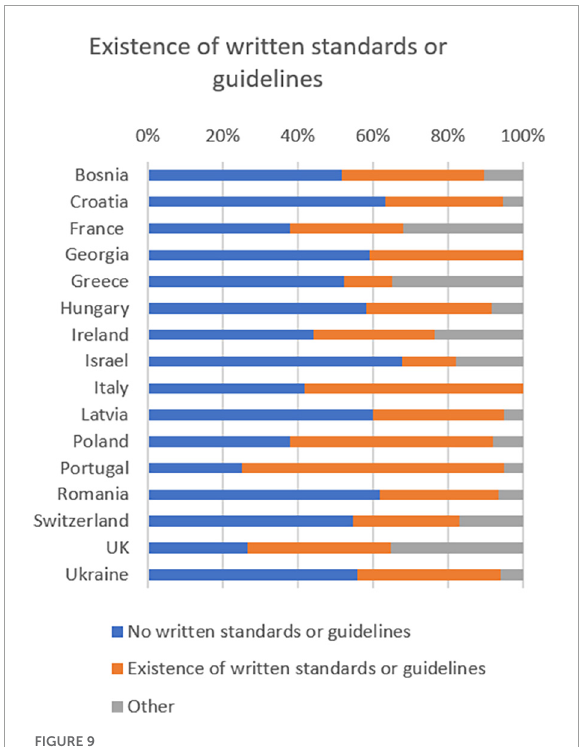
FIGURE9 Intermediate care: existence or written standards or